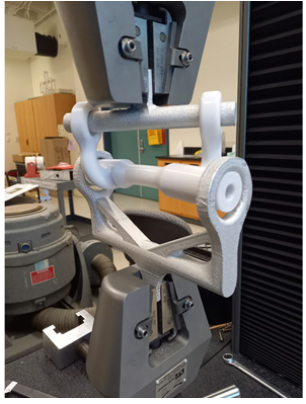
Figure 19. Combined loading specimen in the uniaxial test machine.